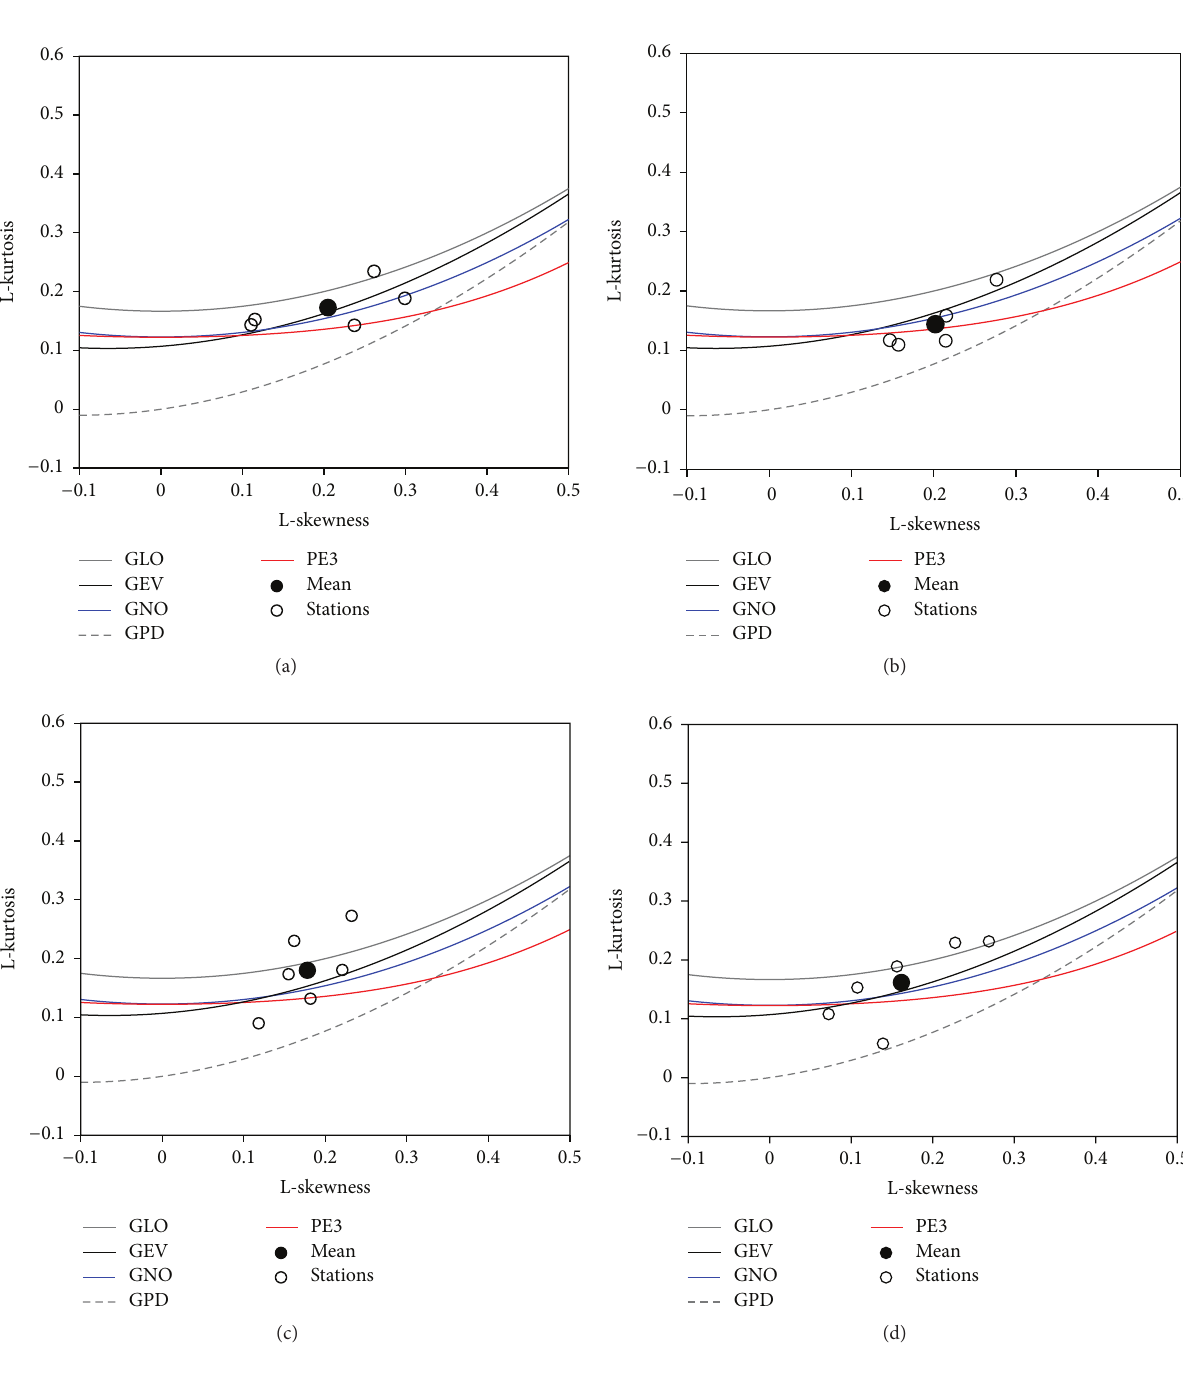
After the determination of the “best-fit” regional